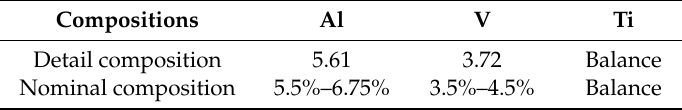
Table 1. The compositions (wt.%) of titanium alloy.